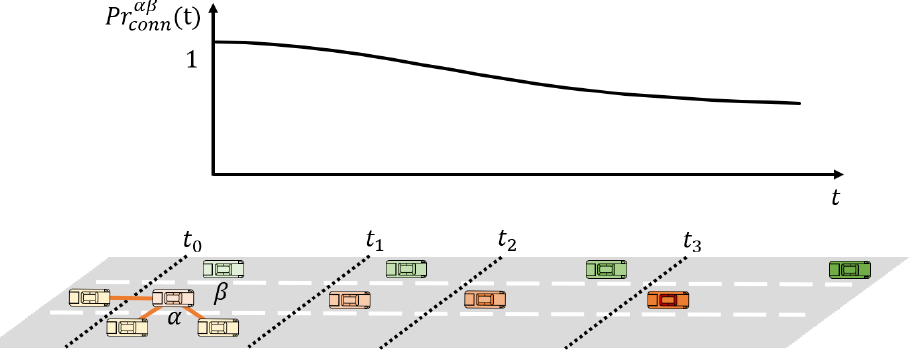
Figure 2. Probability of a connection in one